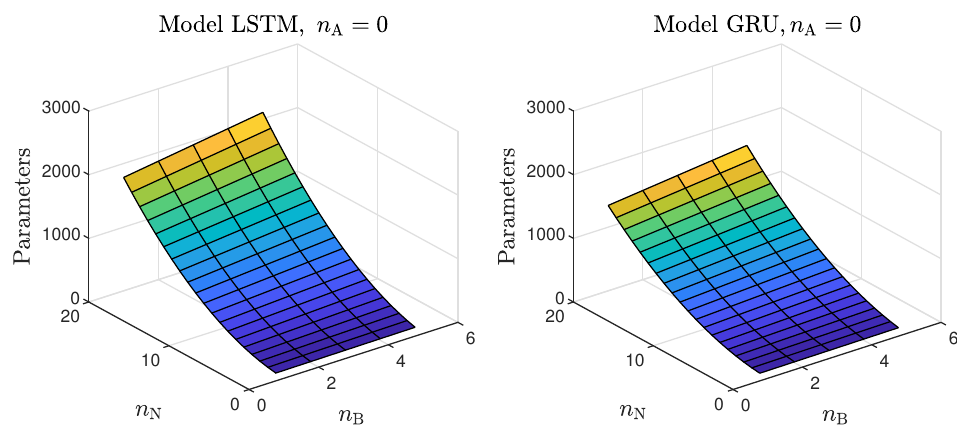
Figure 7. The number of parameters of the LSTM and GRU models as a function of the number of neurons and the order of the dynamics determined by n B ; n A = 0.